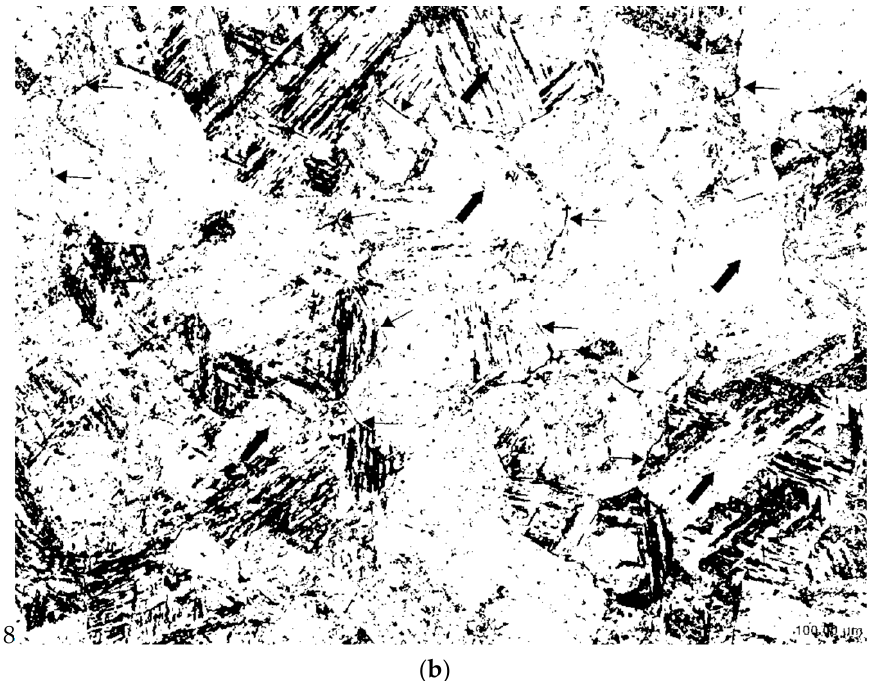
Figure 11. Optical micrograph showing prior austenite grain boundaries as shown by the white arrows in ( a ) and martensitic internal structure as shown by the black arrows in ( b ). Etched in saturated picric acid with sodium alkylate sulfonate (Teepol) (0.38 wt.%) carbon steel.